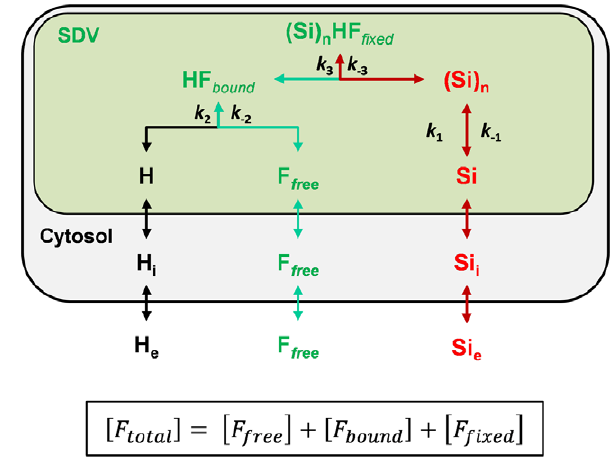
Figure 6. Model used to estimate the equilibrium inside Silica Deposition Vesicles (SDVs). We considered that the fluorescent dye F free freely diffused inside the diatom cells. Inside SDVs, the dye is protonated and accumulates (HF bound ) as a function of SDV pH. Upon SDV expansion, which follows a non-linear kinetics, HF bound concentra- tions increased exponentially. At the same time an important fraction of the dye got entrapped inside the newly-formed silica material ((Si) n HF fixed ). Therefore, [HCK] inside SDVs corresponds to the sum of the free, bound and fixed